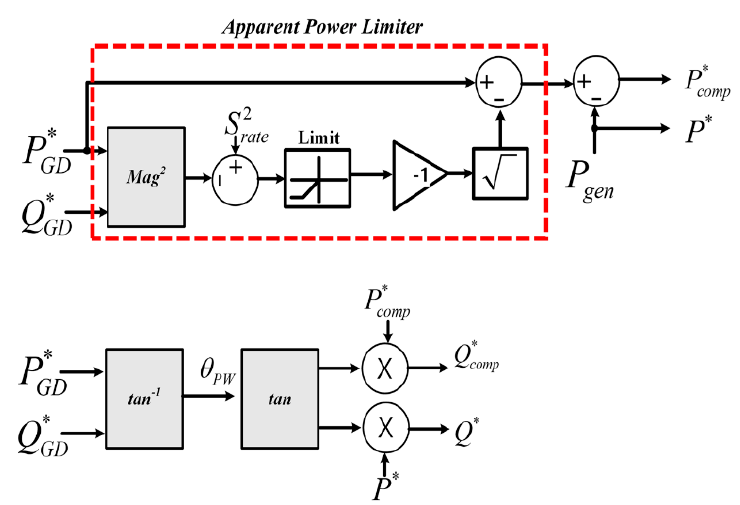
Figure 9. Detailed block diagram of a power distributor.